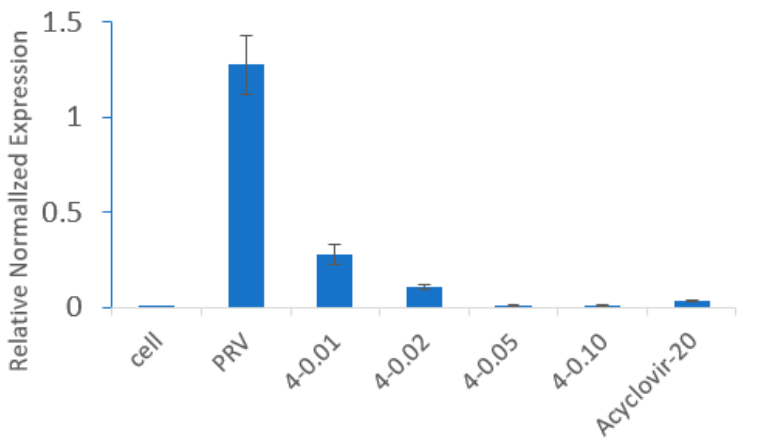
Figure 7. Compound 4 inhibits PRV proliferation. Vero cells were infected with 100 TCID 50 PRV for 1.5 h, and then compound 4 (0.10, 0.05, 0.02, and 0.01 μ g/mL) and acyclovir (20 μ g/mL) were